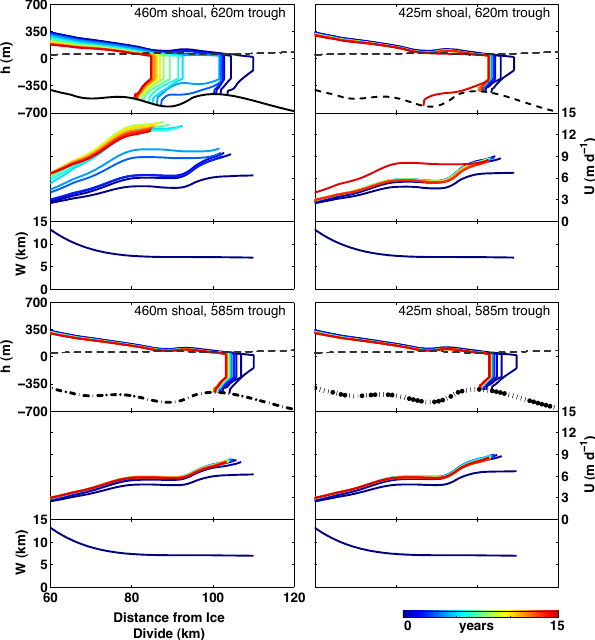
Fig. 2. Modeled annual elevation and speed profiles within the out- let channel (color coded for time, see colorbar) obtained using the 6 width configurations examined herein for 15yr following the onset of the step perturbation. In the elevation profiles, the thin dashed gray line is the ice surface elevation required to remain grounded.